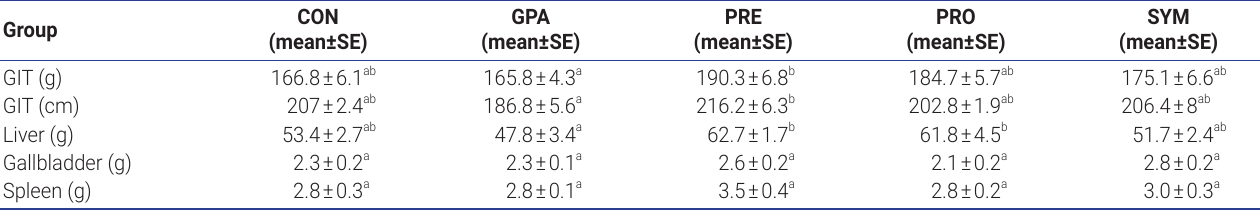
Table 3. Relative weight and length of organs and gastrointestinal tract of broilers feeding with different additives encapsulated at the end of the experiment